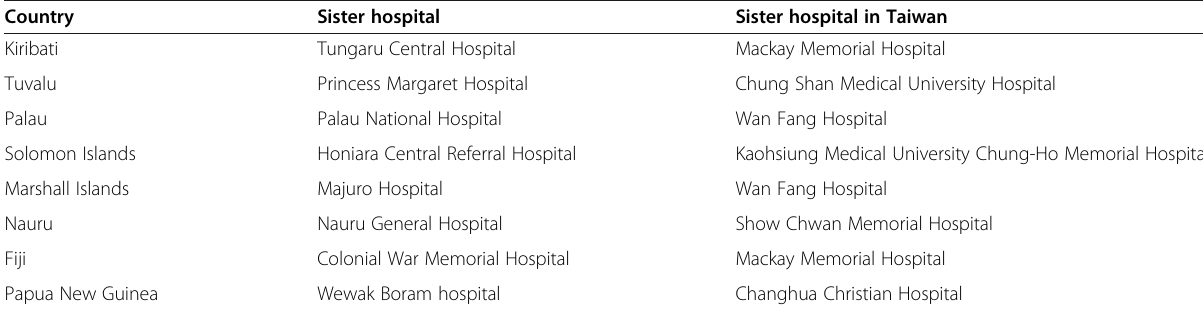
Table 1 Sister hospitals for STMMs to the South Pacific